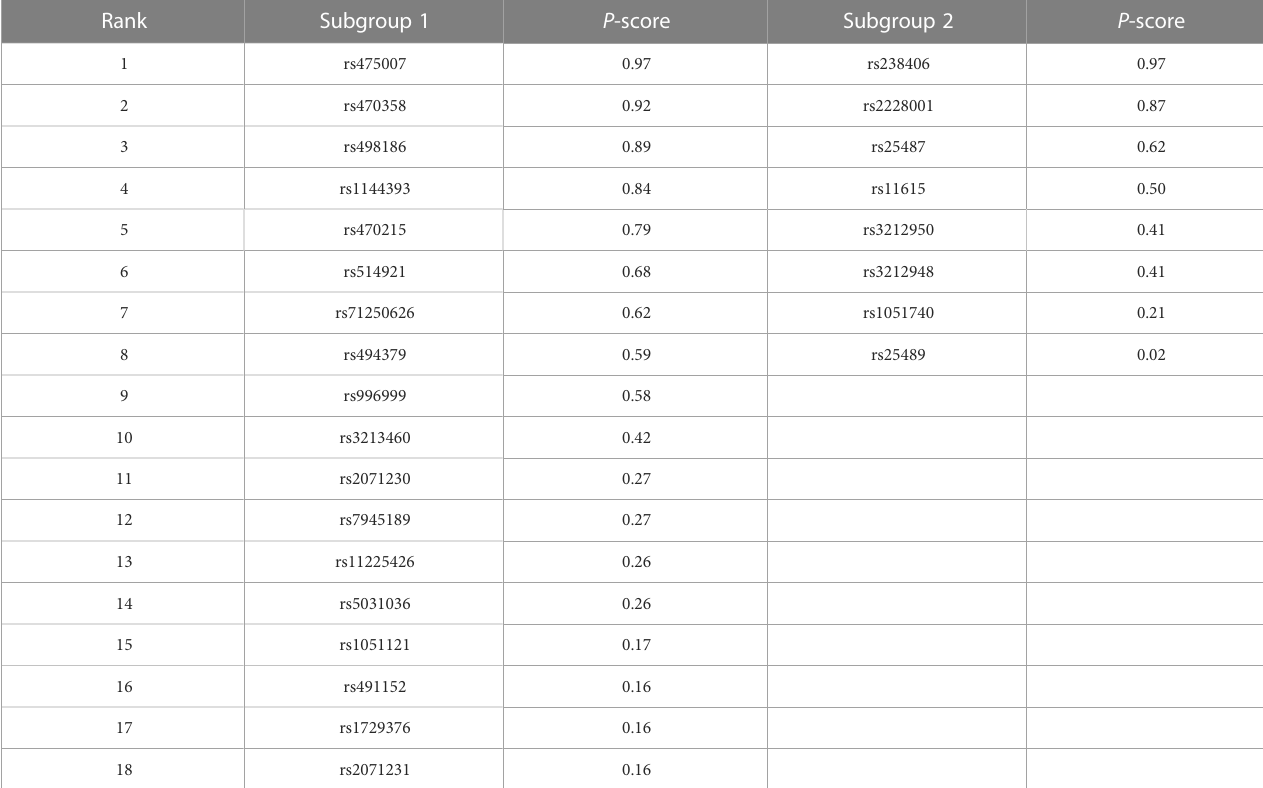
TABLE 5 The rank of the P -score of the SNPs in each subgroup in the dominant model. Rank Subgroup